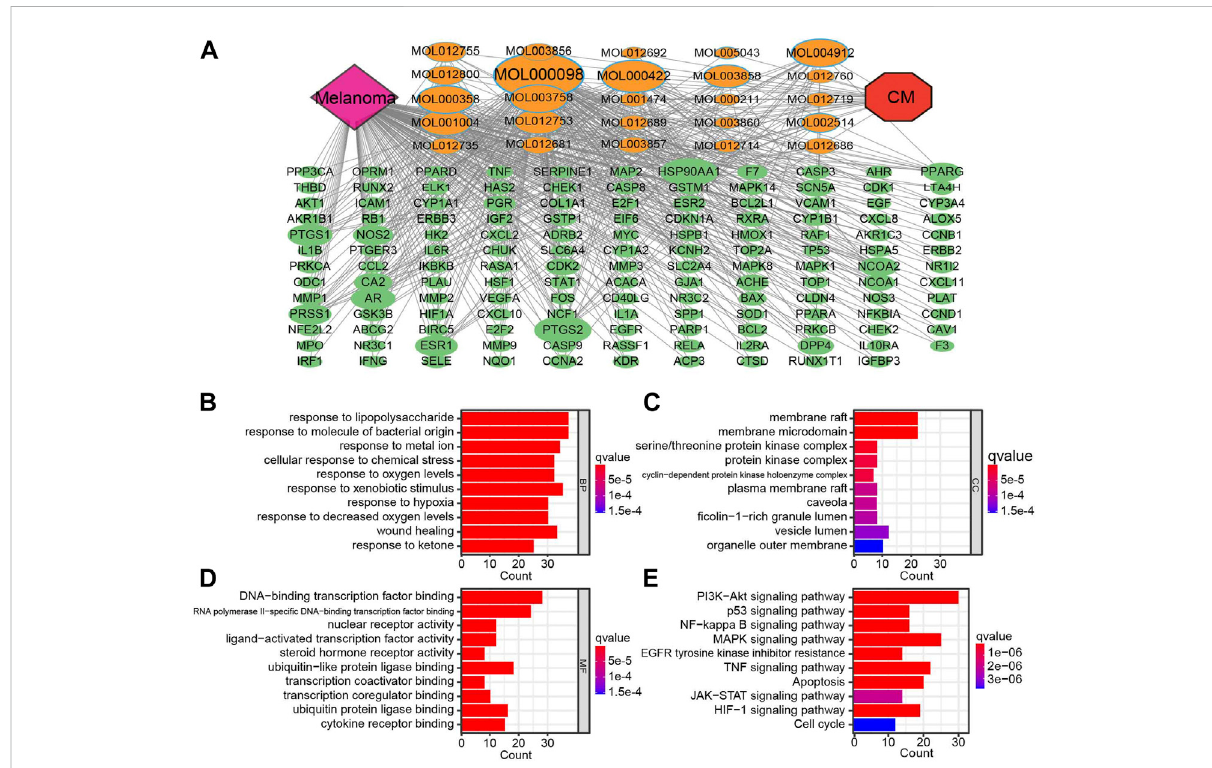
FIGURE 3 The compound-target network for CM on melanoma and enrichment analysis. (A) The purple node represents melanoma. The red node represents CM. The yellow nodes represent candidate active compounds, and the dark green nodes represent potential protein targets. The edges represent the interactions between them, and node sizes are proportional to their degree except for CM and melanoma. The gray connecting lines indicate that each node is interconnected. The top 10 GO terms in (B) biological process (BP), (C) cellular composition (CC), (D) and molecular function (BF) are displayed based on p < 0.05. (E) KEGG analysis for potential targets. The enriched signaling pathways of potential target genes. The Y-axis represents signi fi cant KEGG pathways, and the X-axis represents the count of targets. The gradient of color represents the adjusted p -value. CM: Cortex Mori